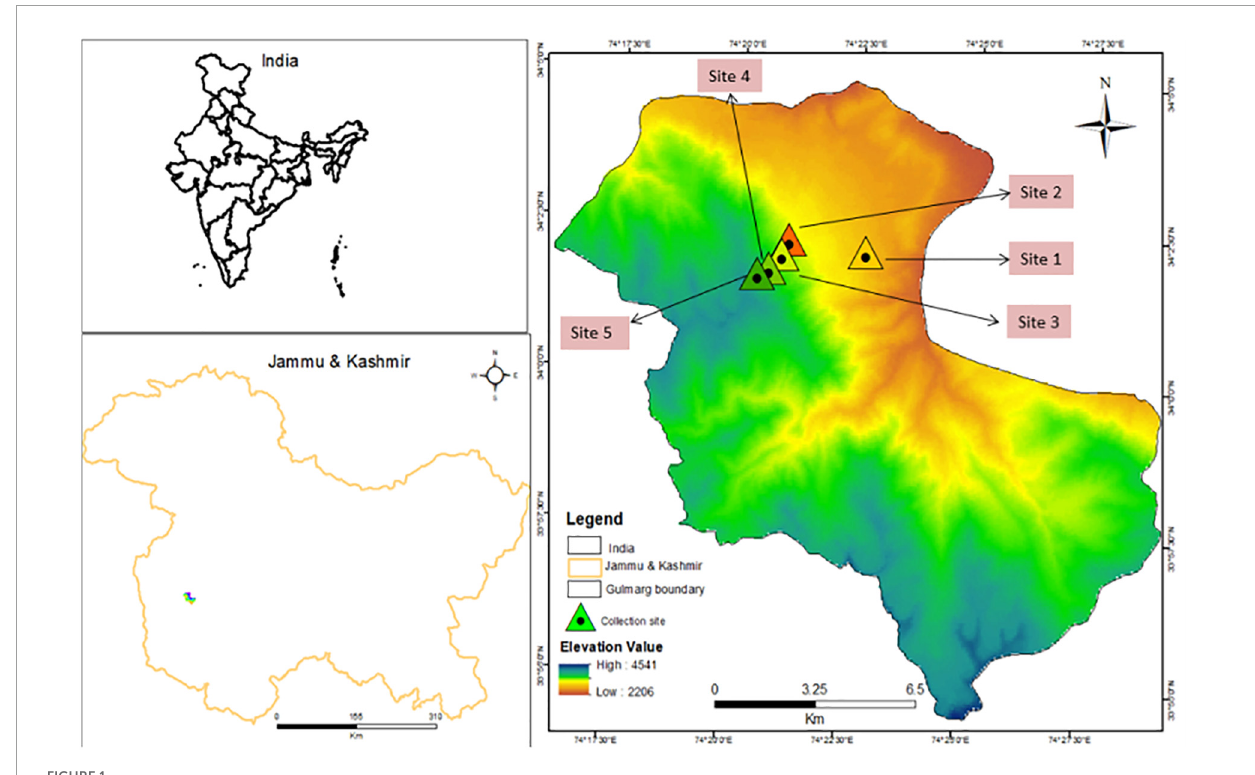
FIGURE1 Map of the study area shows selected sampling sites in Kashmir